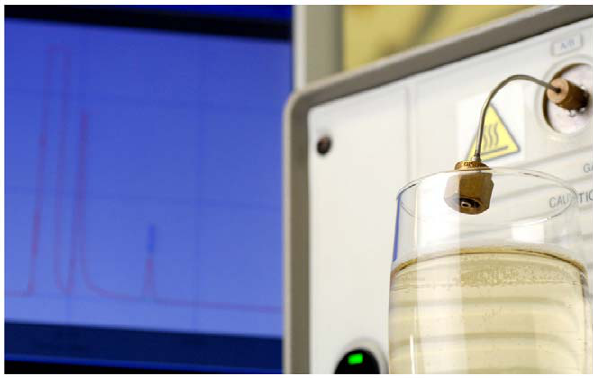
Figure 2. Gas chromatograph injection valve sampling gases in the headspace above the flute. Photograph by Ge´rard Liger-Belair.